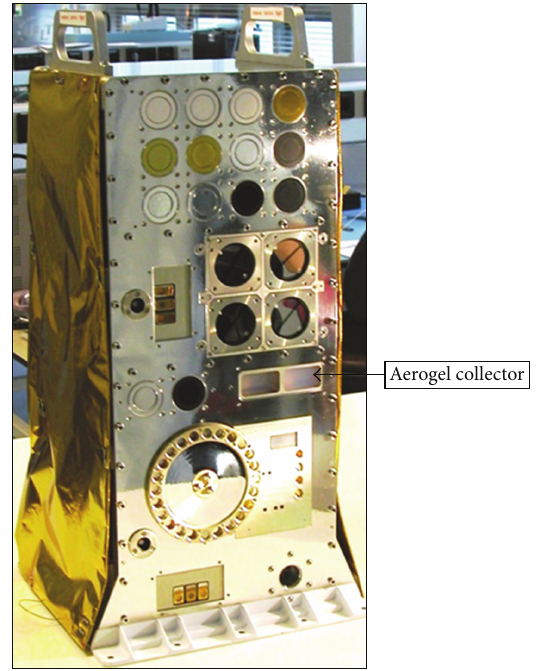
Figure 7: Two panel aerogels on the sensor device has been installed on the International Space Station (CNES property).